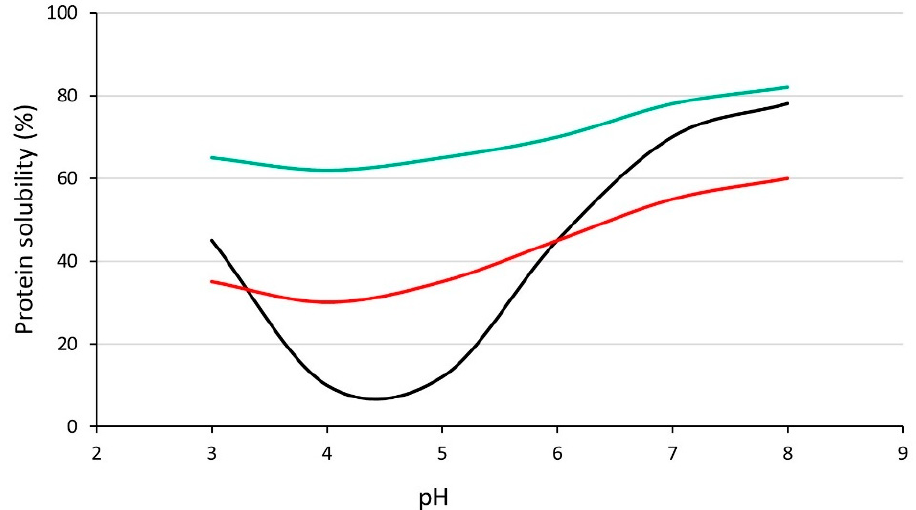
Figure 2. Generalised pH dependent solubility curves showing a typical solubility profile for non- hydrolysed pulse protein and two potential profiles for solubility after hydrolysis. Black: typical pattern for non-hydrolysed pulse proteins; red: hydrolysate with improved solubility near isoelectric point but otherwise reduced solubility; green: hydrolysate with improved solubility across the pH range.